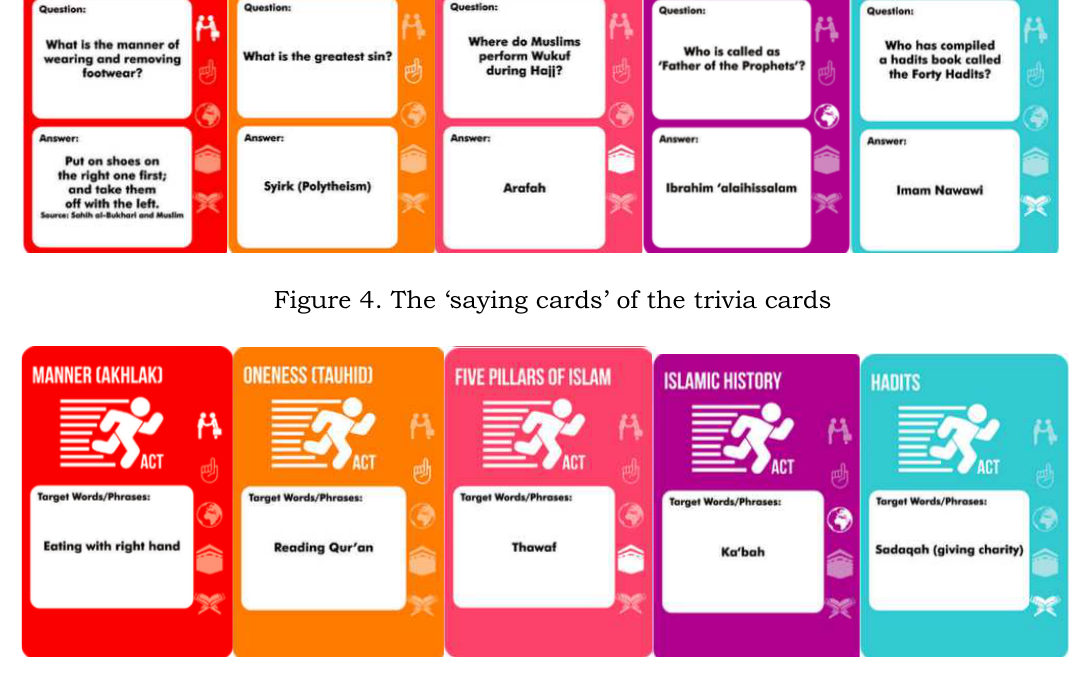
Figure 5. The ‘acting cards’ of the trivia